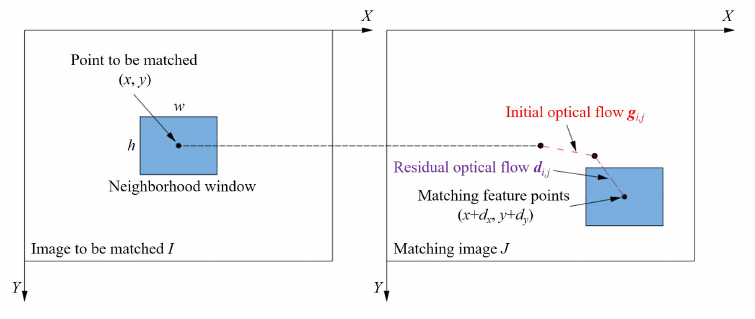
Figure 7. Schematic of optical